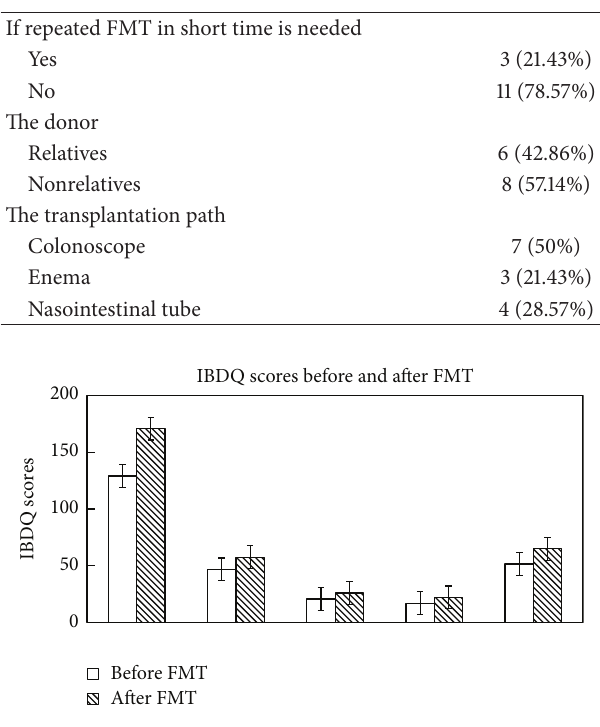
Table 2: Patients’ attitude towards FMT.